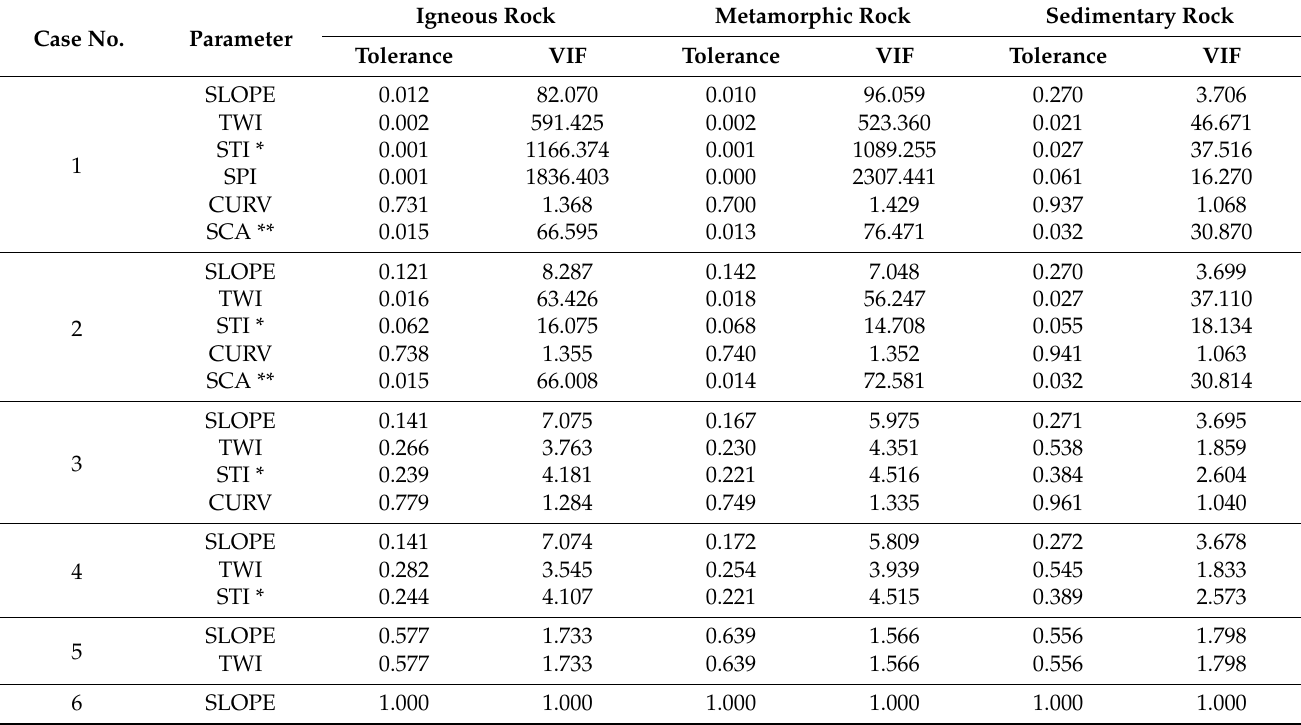
Table 2. The result of multi-collinearity